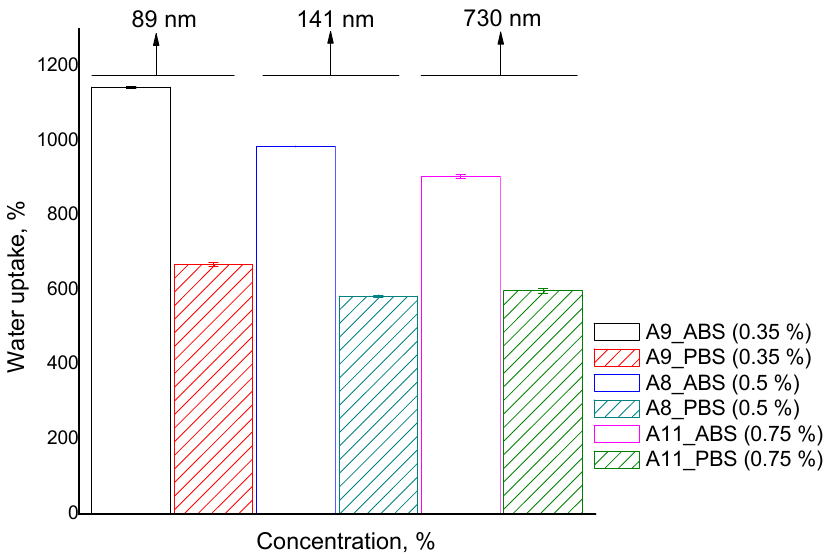
Figure 9. Polymer concentration influence on water uptake for CPH: A9 (0.35%); A8 (0.5%); A11 (0.75%).